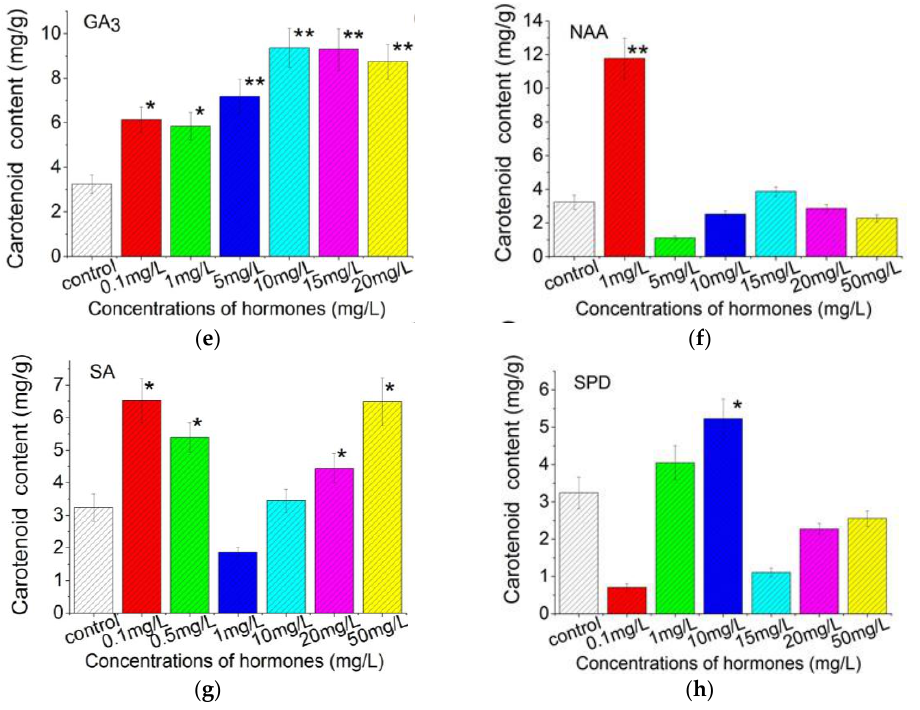
Figure 4. Carotenoid contents of C. pyrenodiosa ZF strain at different concentrations of plant growth regulators: ( a ) 6-BA treatments; ( b ) ABA treatments; ( c ) EBR treatments; ( d ) ETH treatments; ( e ) GA 3 treatments; ( f ) NAA treatments; ( g ) SA treatments; ( h ) SPD treatments.. 2.4. Plant Growth Regulators Induced Lipid Production in C. pyrenoidosa ZF Strain Cells